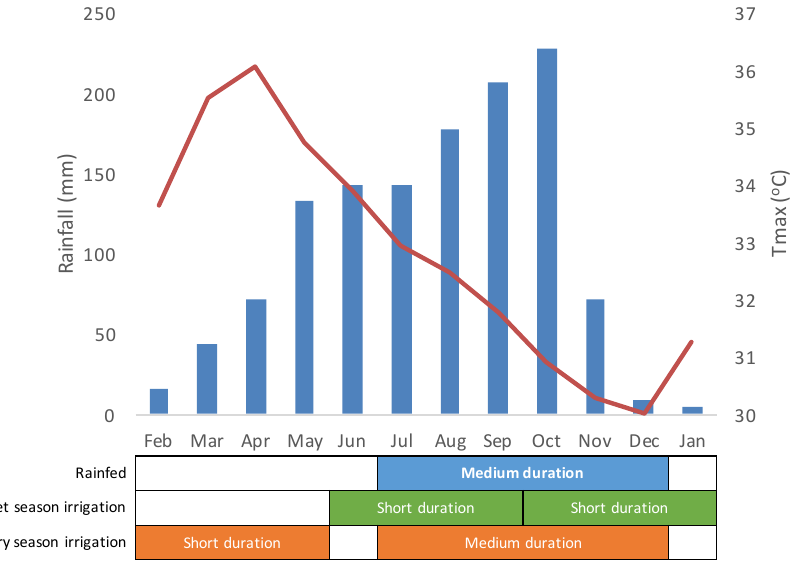
Figure 1. Battambang climate and seasonal rice production cycles (blue columns represent monthly rainfall and the red line represents maximum temperature (°C)).